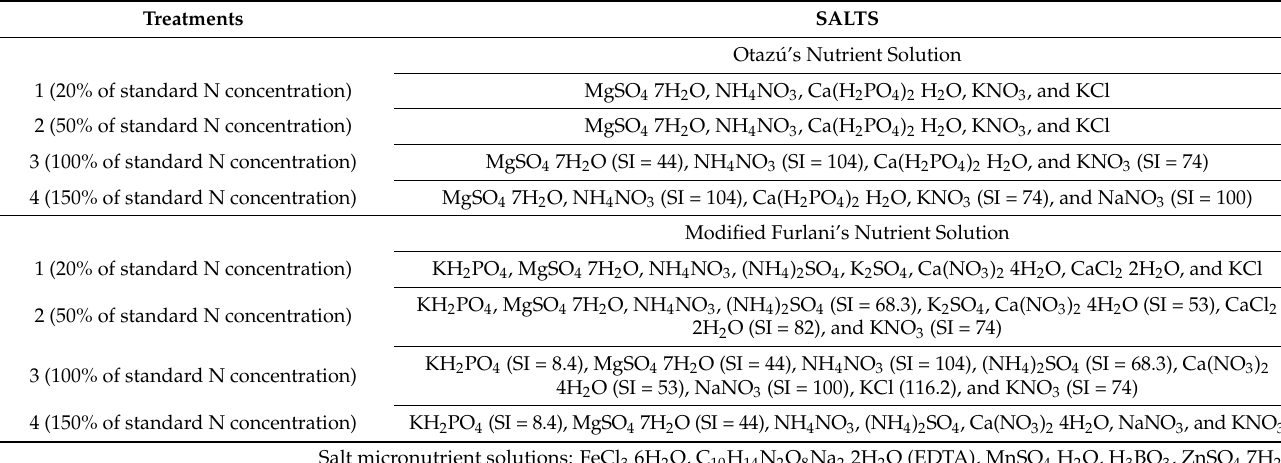
Table 1. Salts reported in nutrient solutions for stock solutions were used to produce nuclear potato seeds in an aeroponic